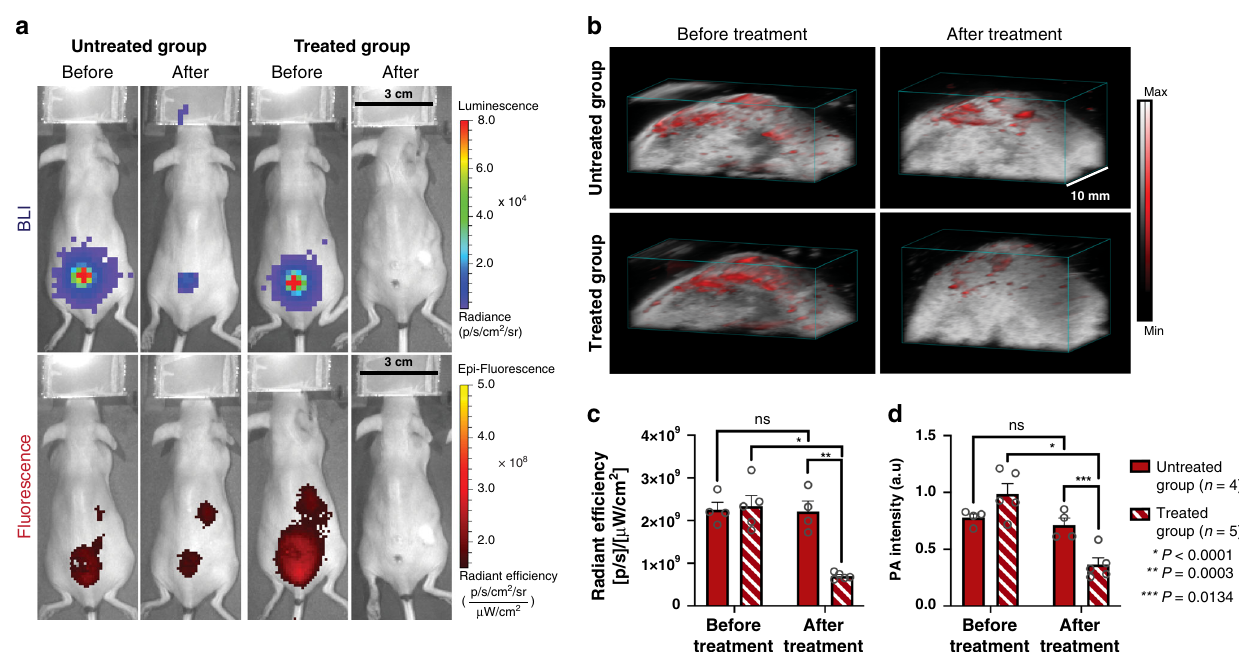
Fig. 6 In vivo evaluation of Cy7-1-maltotriose in a S. aureus wound infection murine model. a BLI and FLI images of mice with a wound infected with 10 6 CFUs of bioluminescent S. aureus 19 h post-injection of Cy7-1-maltotriose without (Untreated Group) and with (Treated Group) treatment with vancomycin for 7 days and before and after treatment. FLI (bottom-Before) shows accumulation of the probe in the S. aureus located by BLI (top — Before). In the untreated group (left panel) both BLI and FLI showcases presence of S. aureus infection in the wound after 7 days (Untreated Group — After). While in the treated group (right panel), complete disappearance of S. aureus infection was observed in the FLI image and con fi rmed by BLI (Treated Group — After). b 3D rendered PA image overlaid on US image of a mouse from Untreated (Top row) and Treated (Bottom row) groups before and after treatment. Images were acquired 20 h post-injection of Cy7-1-maltotriose. Similar to observations in FLI, the Treated group showed lower PA signal post-treatment (bottom right) than that before treatment (bottom left). c Total in vivo fl uorescence signal in wound infected with 10 6 CFUs of bioluminescent S. aureus 19 h after tail vein injection of Cy7-1-maltotriose. Signi fi cant reduction of FLI signal after treating the mice with vancomycin for 7 days in the treated group ( n = 5, P < 0.0001) was observed, while no difference was observed in the untreated group before and after 7 days ( n = 4). d Bar plot representation of the quanti fi ed average PA signal intensity in the PA images acquired 20 h after injection of Cy7-1-maltotriose before and after antibiotic treatment. PA quanti fi cation data showed a similar trend to that obtained from FLI images. Bar graphs show mean and S.E.M. Statistical analysis was performed using two-way ANOVA. ns no statistically signi fi cant difference ( P > 0.05). The source data underlying Fig. 6c and d are provided in a Source Data fi